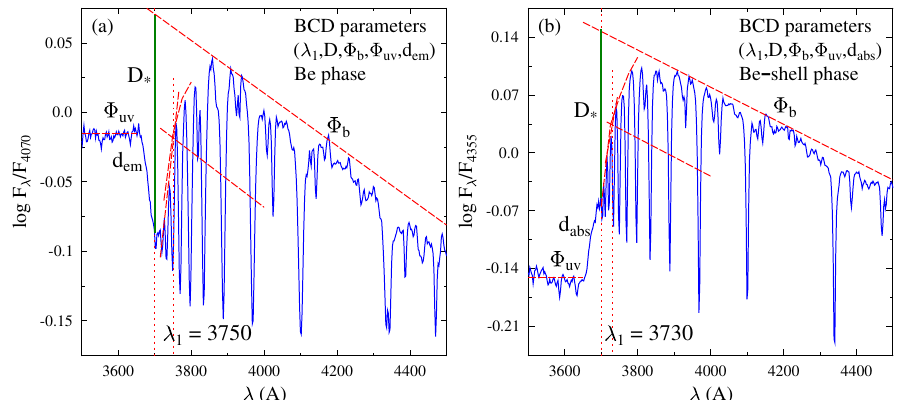
Figure 2. Same as in Figure 1, but in ( a ) is shown the energy distribution of a Be star, whose second component of the BD is in emission (flux excess). In ( b ), the spectrum is for a Be star in shell phase, where the second component of the BD appears in absorption (flux deficiency). As for Figure 1, spectra were obtained in the Complejo Astronómico El Leoncito (CASLEO), San Juan, Argentina, with the Boller and Chivens spectrograph mounted on the J. Sahade 2.15 m telescope. Adapted from Aidelman et al.